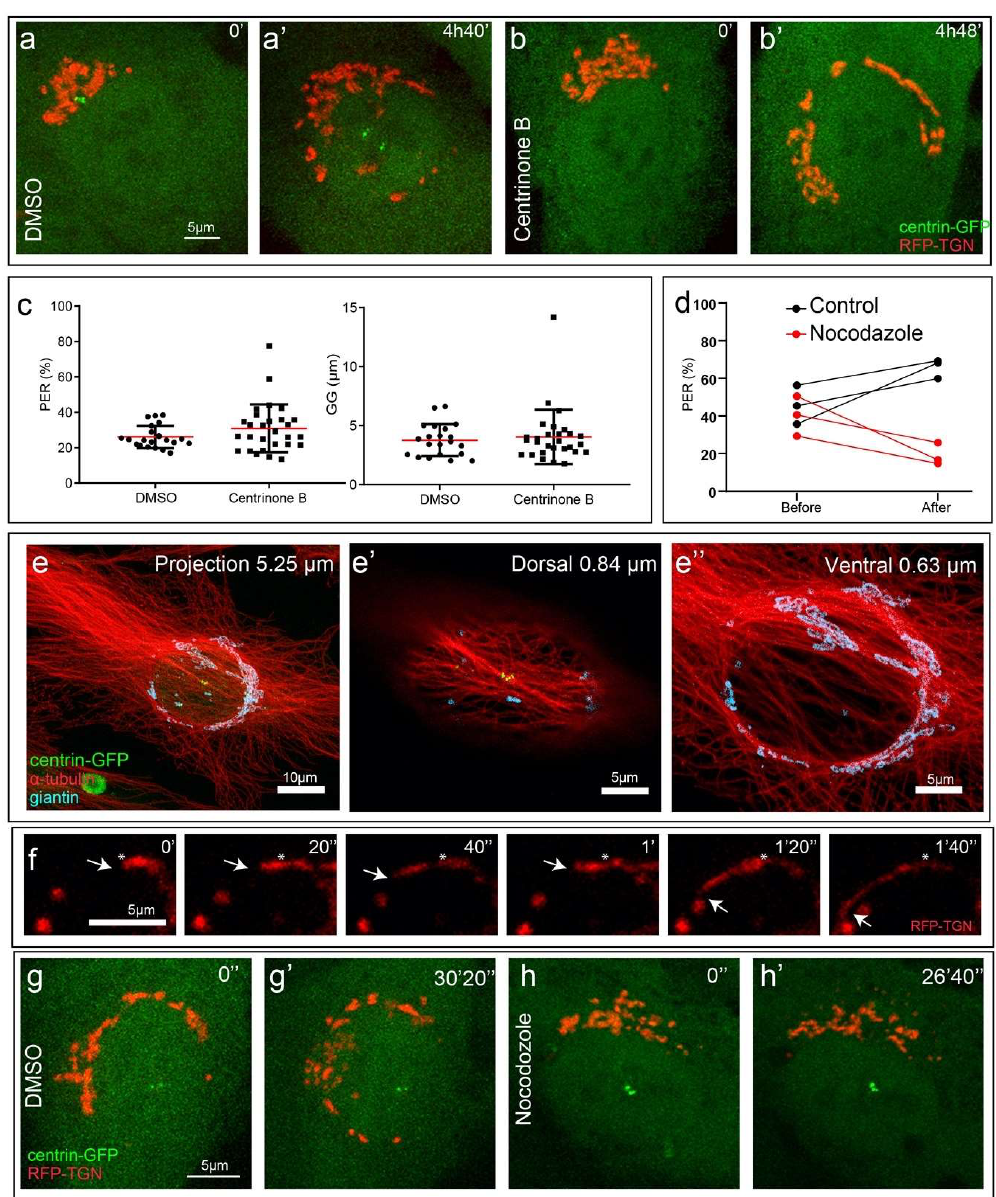
Figure 3. Golgi stretching around the nucleus is centrosome-independent and microtubule-dependent. ( a – b’ ) Frames from a time-lapse imaging sequence of RPE1 cells stably expressing Golgi (RFP-TGN, red) and centrosome markers (centrin1-GFP, green). E mode progression over 5 h in ( a ) control cell or ( b ) cell pretreated by Centrinone B for 72 h. Scale 5 µm. Time, hours, minutes. ( c ) Quantification of PER and GG in fixed S-phase cells (BRDu-positive) pretreated with DMSO or Centrinone B for 72 h. Student t -test showed no significant differences between DMSO and Centrinone B-treated cells for either PER or GG. n = 49. Error bars, SD. Red line, mean. ( d ) Change of Golgi extension during 30 min live-cell imaging of cells with and without MTs. Cells pretreated on ice for 45 min were recorded in the presence of DMSO (control) vs. nocodazole. PER index before and after imaging is shown. n = 3. ( e – e’’ ) Localization of the Golgi (giantin, cyan) and MTs (α-tubulin, red) in E mode, immunostaining, centrin1-GFP (green). ( e ) Cell overview shown as a maximum intensity projection of entire laser scanning confocal stack (5.25 µm-thick). Scale 10 µm. ( e’ , e” ) Maximum